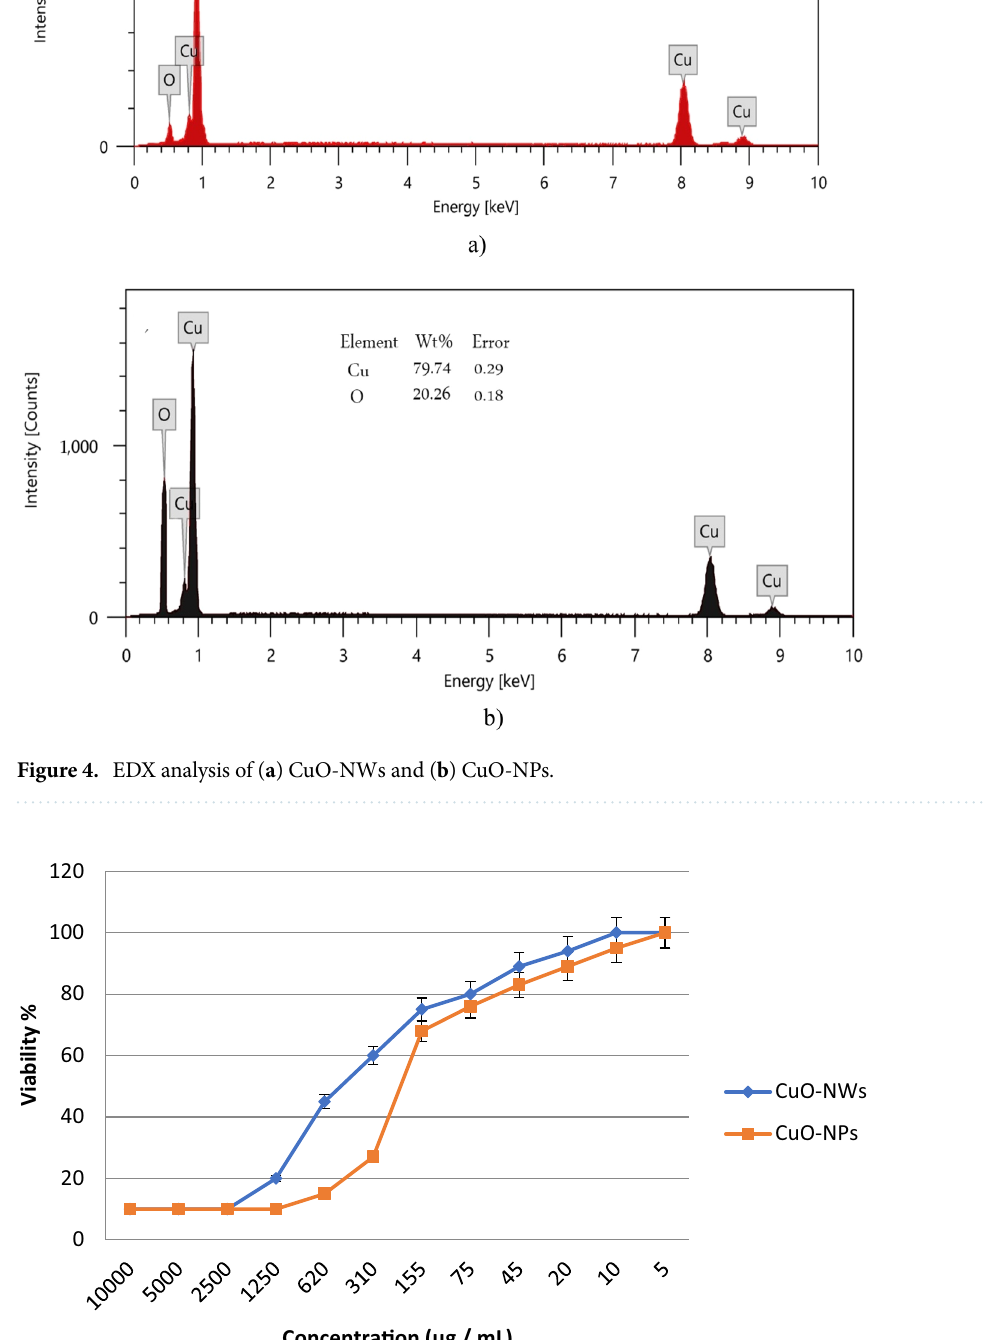
Figure 5. The percentage of normal fibroblast cells viability upon treatment with CuO-NWs & CuO-NPs one at a